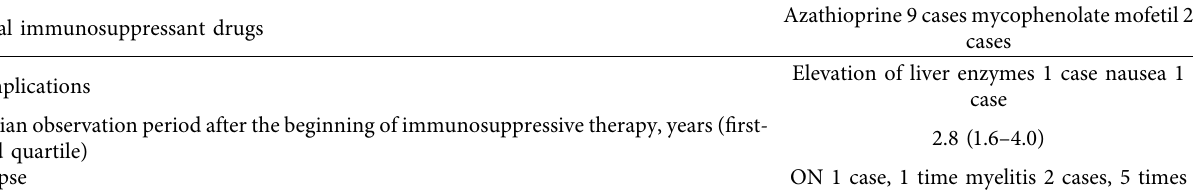
Table 2: Immunosuppressive therapy.